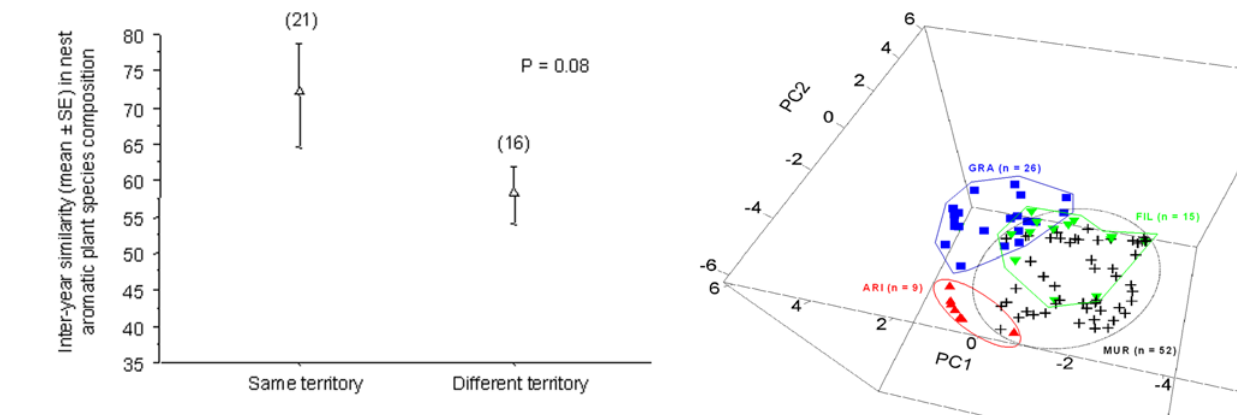
Figure 1. Similarity in the aromatic plant species composition of nests from breeding attempts made by the same female, either in the same territory or in different territories. Similarity was calculated using the Bray-Curtis index. Sample sizes are indicated in parentheses. The P-value results from a Student’s t-test (see Methods). doi:10.1371/journal.pone.0005104.g001 Table 2. Factors of variation in aromatic plant species composition of blue tit nests over successive years, as tested by t-tests comparing inter-year similarity in aromatic plant composition (see Materials and Methods).